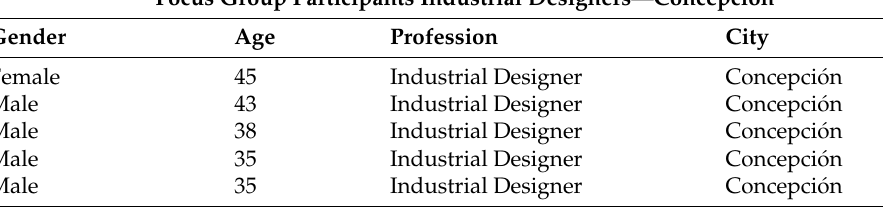
Table A3. Focus group participants of the study (part